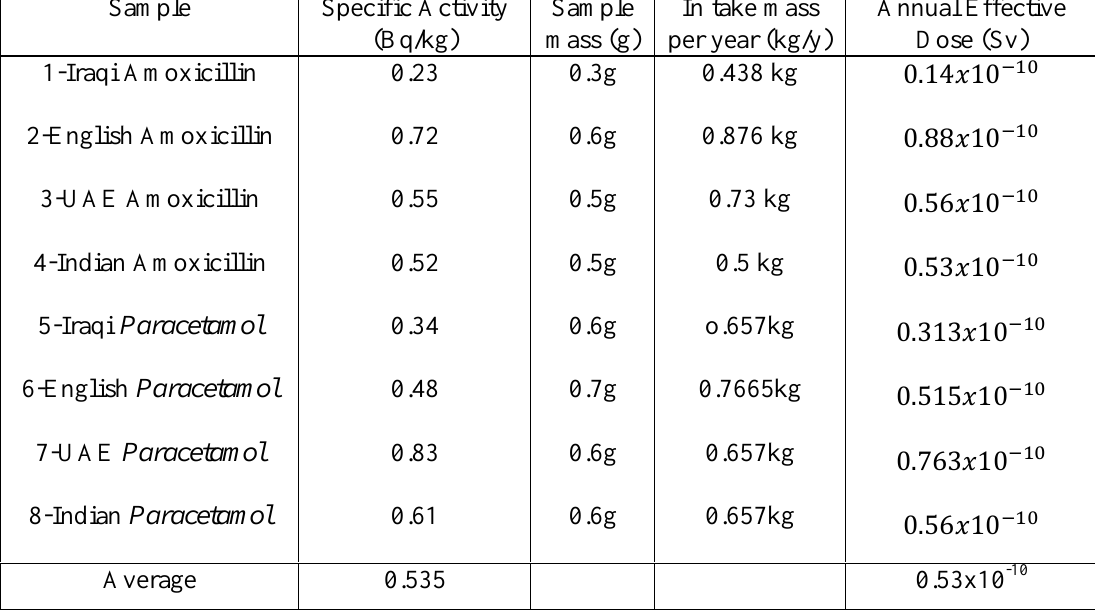
Table 3: Specific activity, sample mass, in take per year and annual effective dose of 214 Pb for all